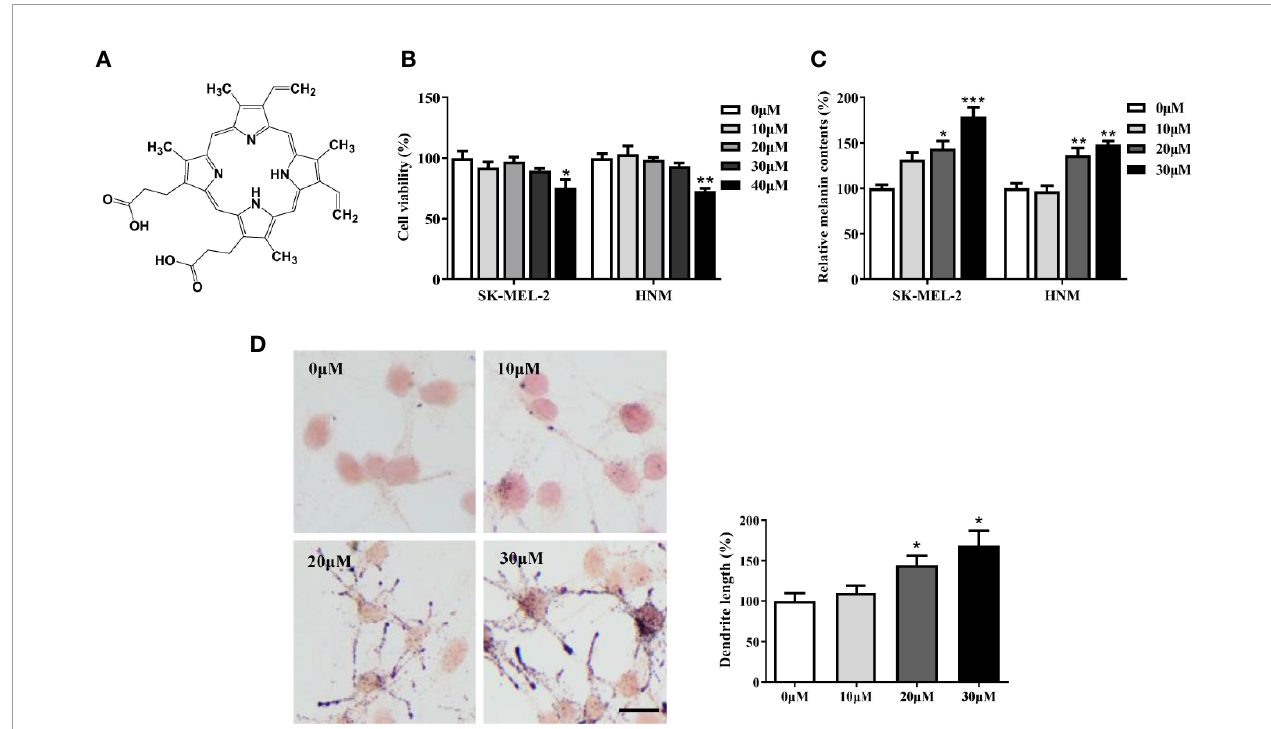
FIGURE 1 | Protoporphyrin IX (PPIX) induced hyperpigmentation in melanocytes. (A) The chemical structure of PPIX. (B) After incubation of with various concentrations (10-40 m M) of PPIX for 48 h, cell viability was determined using MTT assay. (C) SK-MEL-2 and HNM were treated with PPIX (10, 20, and 30 m M) for 48 h, and melanin contents were measured. (D) SK-MEL-2 cells were treated with PPIX for 48 h and then stained with Masson-Fontana ammoniacal silver stain. Bar = 20 m m. Total length of dendrites per cell was measured on the pictures using ruler. Data are expressed as the mean ± SEM (n = 3). *p < 0.05, **p < 0.01, ***p < 0.001 versus non-treated